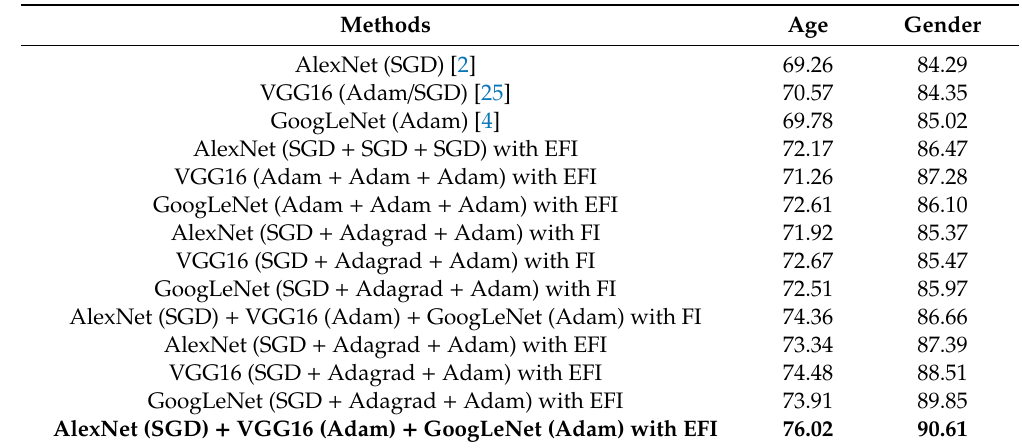
Table 5. Classification results of the CIA database by the di ff erent